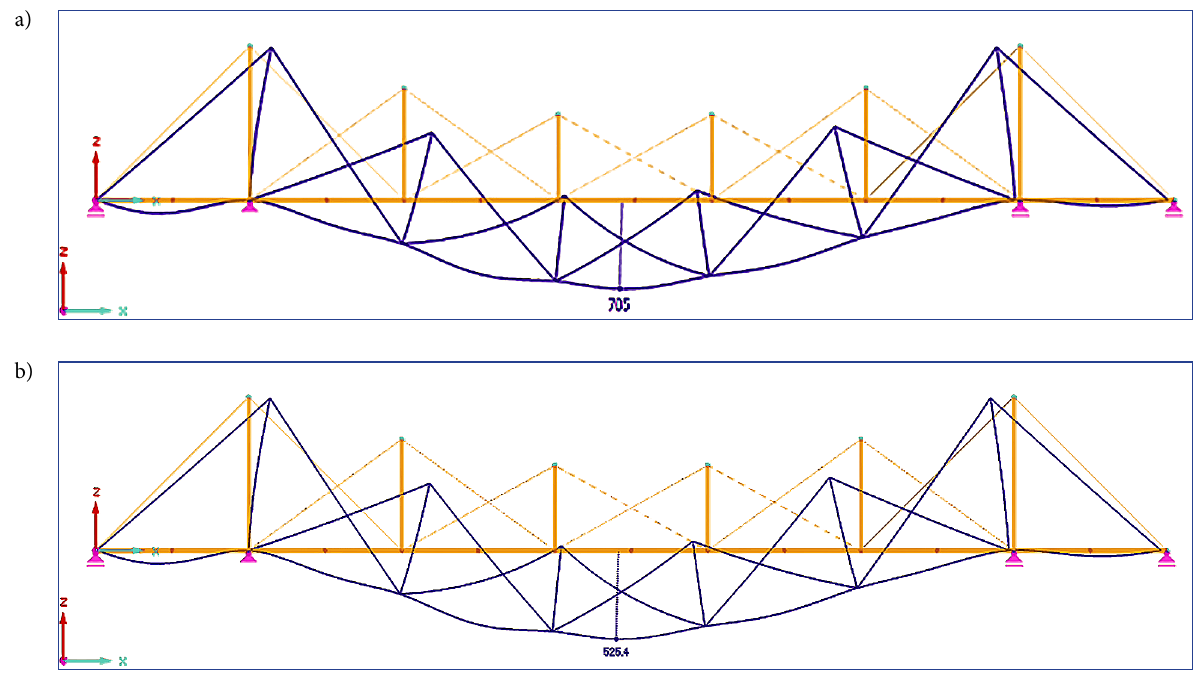
Figure 8. Varying pylons bridge. Deflections: a) under symmetrical loading; b) under